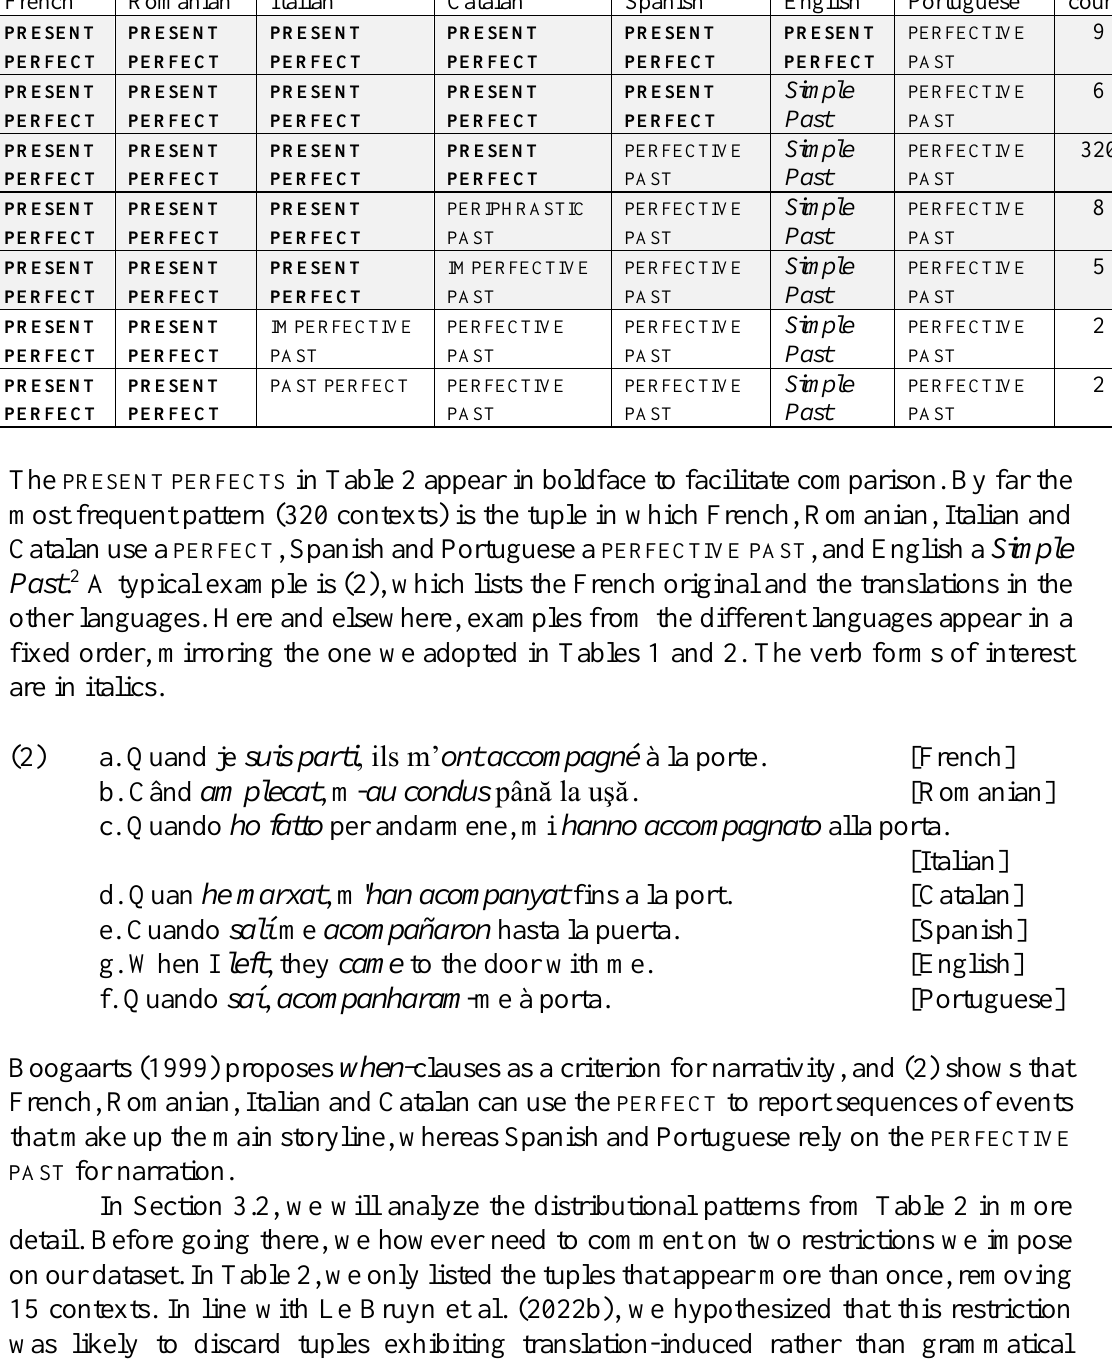
Table 2 . Seven-tuples in the Camus Passé Composé dataset with occurrence >1